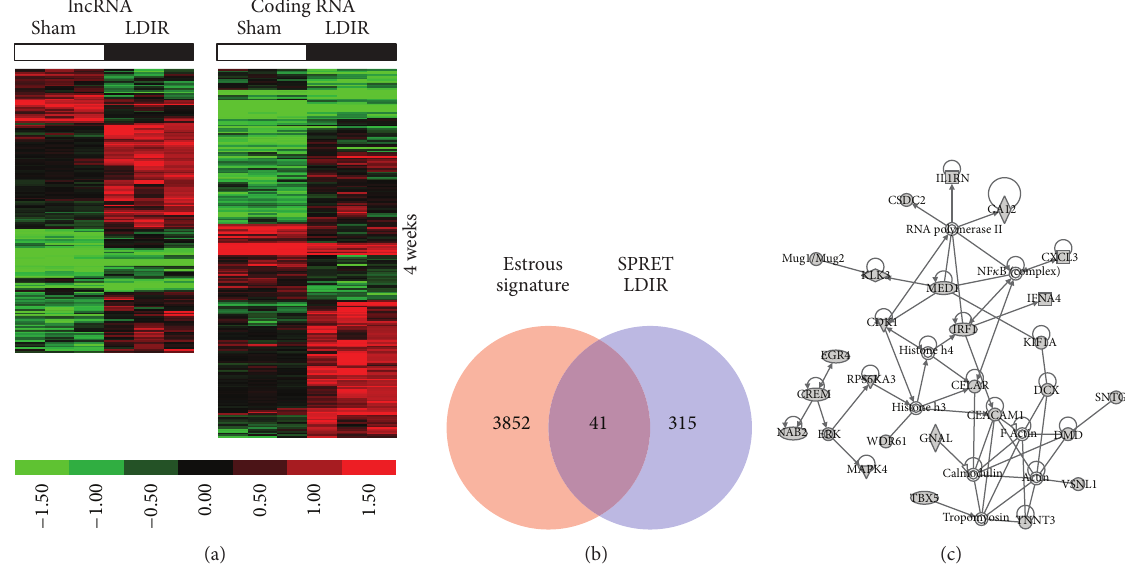
Figure 3: Significant lncRNA and coding RNA expression changes after LDIR exposure in mammary tissues of SPRET/EiJ mice. (a) Hierarchical clustering of lncRNAs (left) and coding RNAs (right) differentially expressed (fold-change 1.5; 𝑝 < 0.05 ) in mammary gland tissues of SPRET/EiJ mice at 4 weeks after sham or LDIR exposure. Increased expression indicated in red and decreased expression in green. (b) Comparison of genes differentially expressed after low-dose radiation with a gene signature containing genes whose expression significantly changes in the mammary gland across the female estrous cycle. (c) The most significant gene interaction network of estrous cycle independent genes differentially expressed after LDIR (see Figure S3 for annotation of molecular shapes used in the